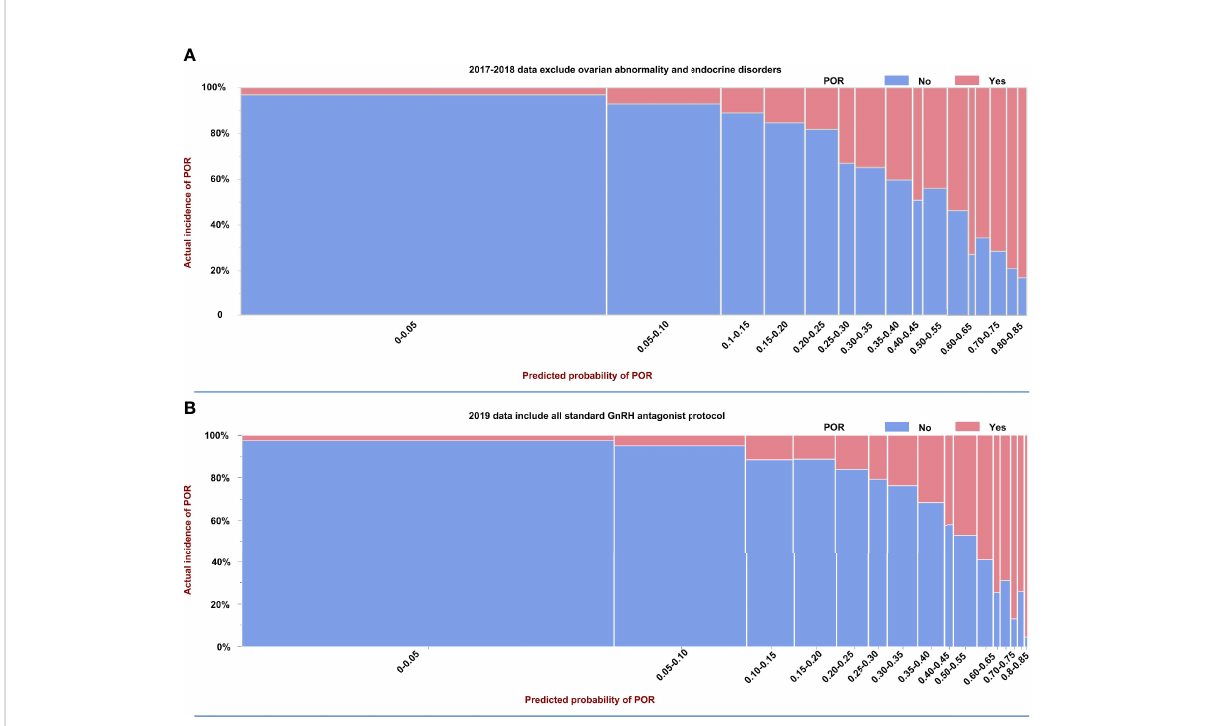
FIGURE 1 Prevalence and predicted probability of poor ovarian reserve (POR) in model building and external validation data. (A) Model building based on selected 2017 – 2018 data excluded women with ovarian abnormalities and endocrinopathies, and (B) the external validation data used unselected 2019 data including all standard GnRH antagonist